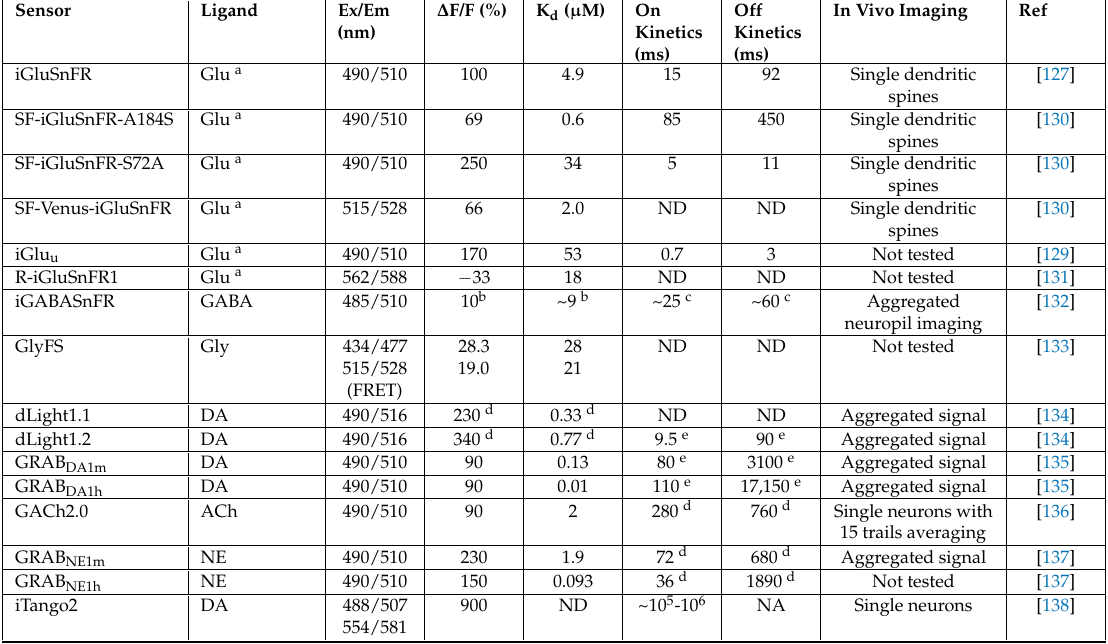
Table 3. Characteristics of selected genetically-encoded fluorescent neurotransmitter